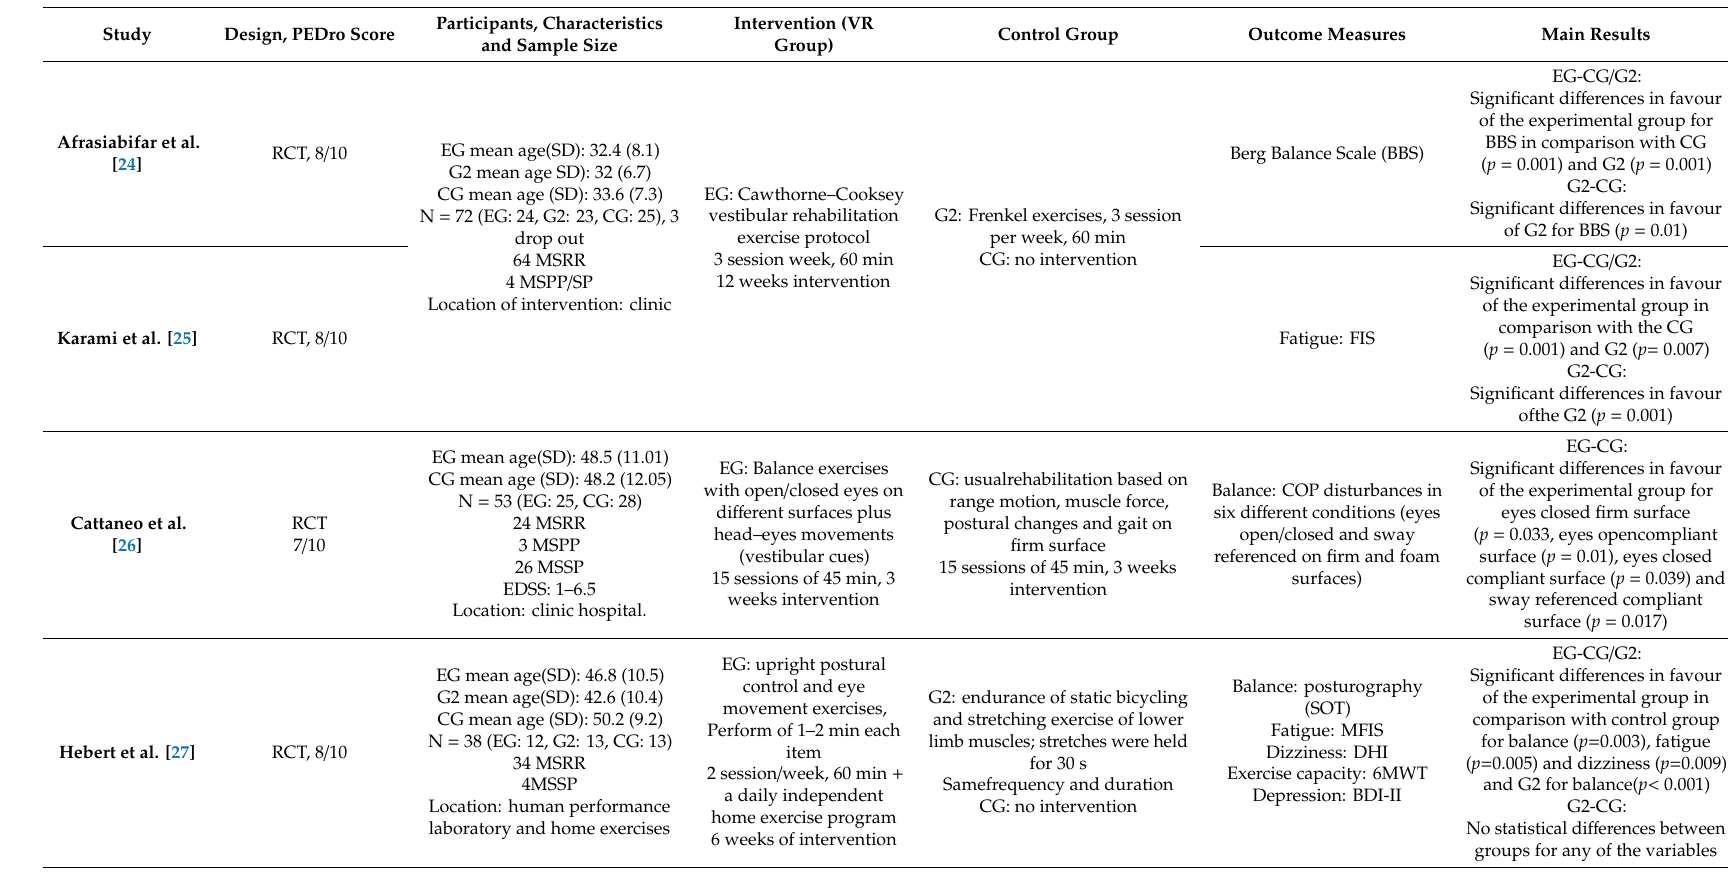
Table 2. Main characteristics of the studies